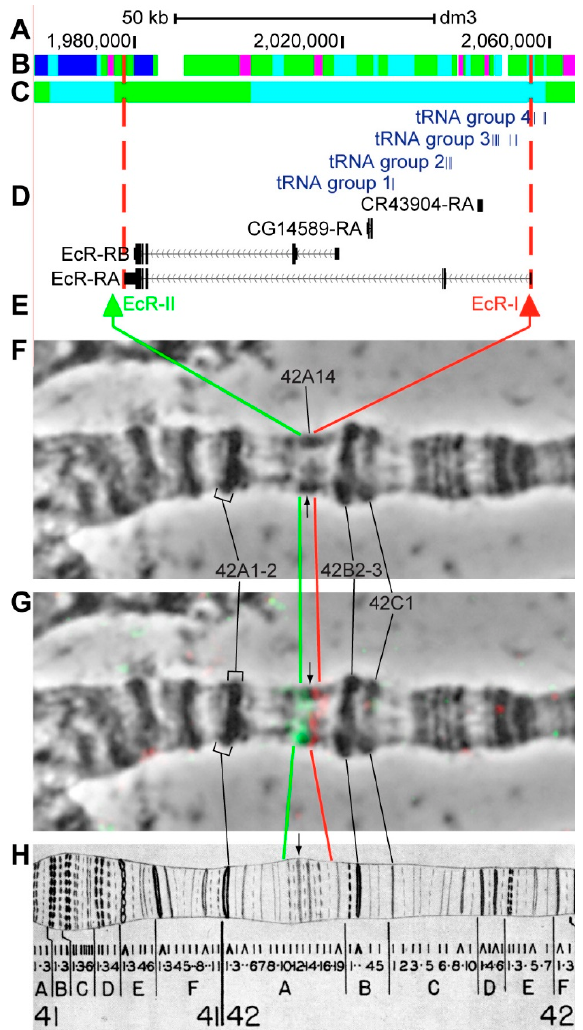
Figure 16. Localization of the EcR gene in the 42A region (the gene is bound by red dotted lines). (A) the scale (kb) and genomic coordinates (bp); (B) the four chromatin-state model [39]; (C) the chromatin condensation level model [32]; (D) genes location (arrow lines show the gene orientation and black bars indicate the location of gene exons); (E) probes location; (F) phase-contrast micrograph of the region; (G) combined FISH signals; and, (H) C. Bridges and P. Bridges’ chromosome map [55]. tRNA